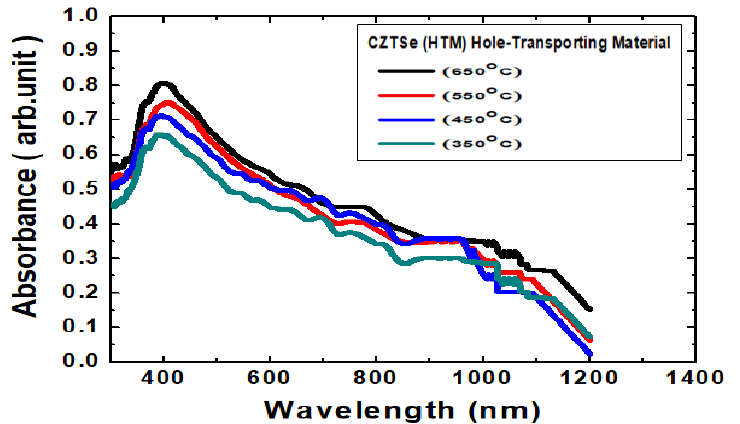
Figure 6. The absorbance spectra of Cu 2 ZnSnSe 4 HTM nano-films after the various annealing temperatures.